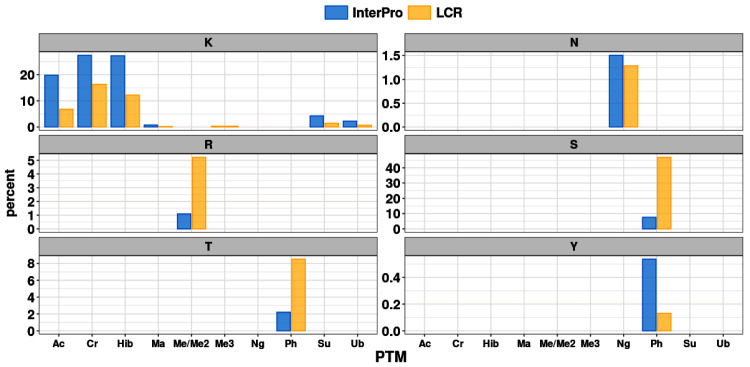
Mapping of post-translational modifications on the corresponding residue.The relative representation (percent) of post-translational modifications was analysed in the InterPro domains (blue) or LCRs (yellow), after normalisation by the frequency of each amino acid in the corresponding regions/domains.